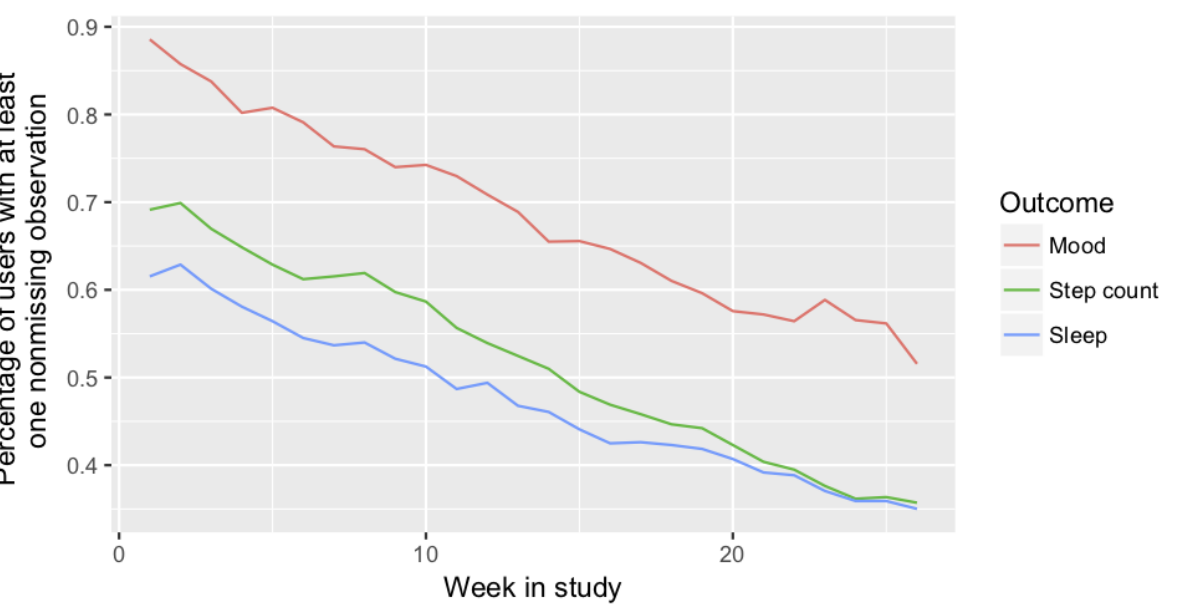
Figure 3. Percentage of interns with at least one nonmissing sleep, step, or mood observation for each week in the